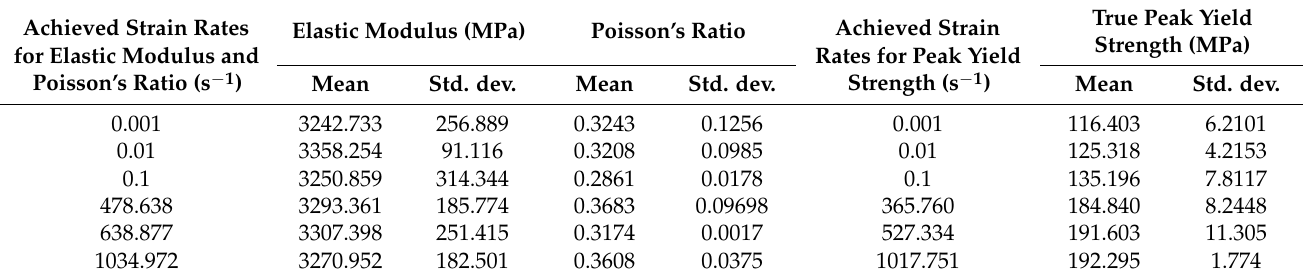
Table 2. Summary of the results of the RMT6 epoxy resin during compression at different strain